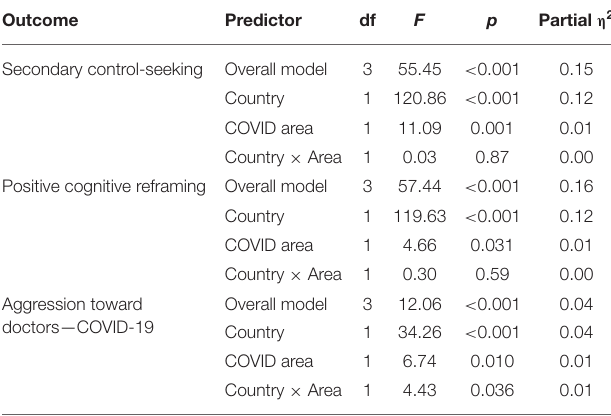
TABLE 7 | ANOVAS of country, living in COVID-19-affected areas, and their interaction on secondary control-seeking, positive cognitive reframing, and aggression toward doctors in the COVID-19-specific scenarios (Study